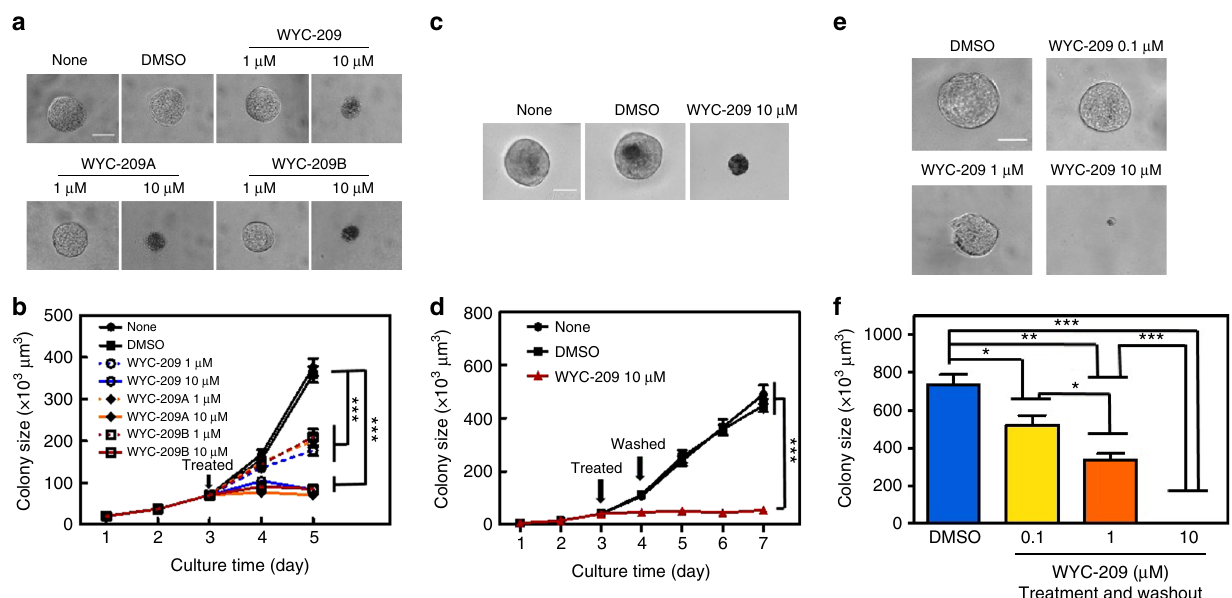
Fig. 3 Inhibition of tumor cell colony growth by WYC-209 with or without washout. a Murine melanoma cells were cultured in 90-Pa fi brin gels for 3 days and then treated with medium alone (None), DMSO (0.1% DMSO-containing medium), 1 or 10 μ M WYC-209, 1 or 10 μ M WYC-209A, WYC-209B. Representative images of colonies on day 5; Scale bar, 50 μ m. b Summarized data. Mean± s.e.m.; n = 15 samples; three separate experiments; *** P < 0.001. c Representative images of colonies on day 7: None: untreated; DMSO: treated with 0.1% DMSO as a vehicle; WYC-209 10 μ M: 3 days after WYC-209 was washed out; Scale bar, 50 μ m. d Drugs were added on day 3 and washed out on day 4; the cells were cultured till day 7. Mean ± s.e.m.; n = 15 samples; three separate experiments; *** P < 0.001. e WYC-209 abrogates colony formation of TRCs. DMSO: Control B16-F1 cells, cultured in 90-Pa 3D fi brin gels and treated with 0.1% DMSO on day 0 for 5 days, were then re-plated into 90-Pa 3D fi brin gels as single individual cells for 5 days without treatment. WYC-209 0.1 μ M, 1 μ M, or 10 μ M: Control B16-F1 cells, cultured in 90-Pa 3D fi brin gels and pretreated with WYC-209 on day 0 with various concentrations for 5 days, then after washing out WYC-209, the cells were re-plated into 90-Pa 3D fi brin gels for 5 days. Representative images of colonies on day 5 (all colonies started as a single cell on day 0); Scale bar, 50 μ m. f Summarized colony sizes on day 5. Mean± s.e.m.; n = 15 samples; three separate experiments; * P < 0.05; ** P < 0.01; *** P < 0.001. Student ’ s t -test was used in all